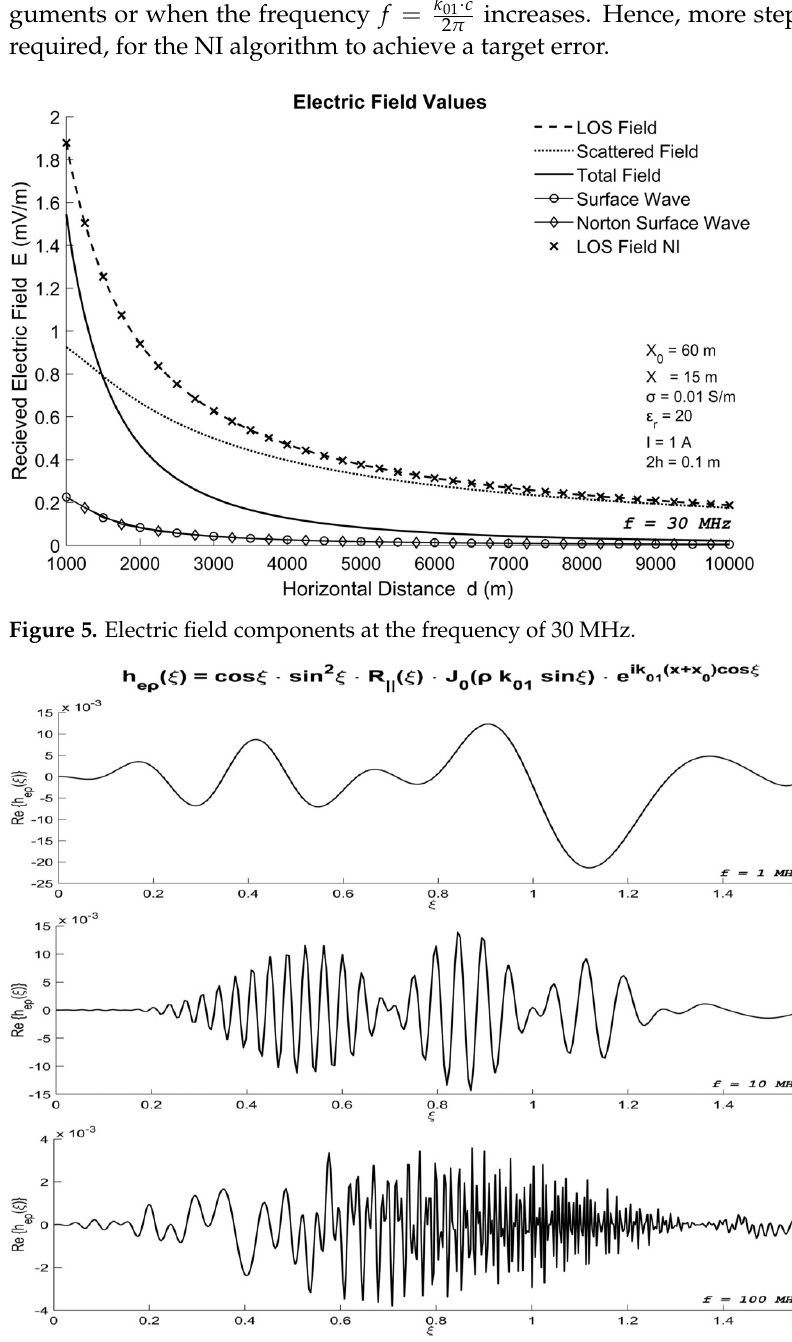
Figure 6. Integrand behavior of (19). The real part of the ρ -component of the first integral expression of (19) is illustrated for f = 1,10,100 MHz. The horizontal distance ρ is 1 km, and the T–R heights are X 0 = 60 m and X = 15